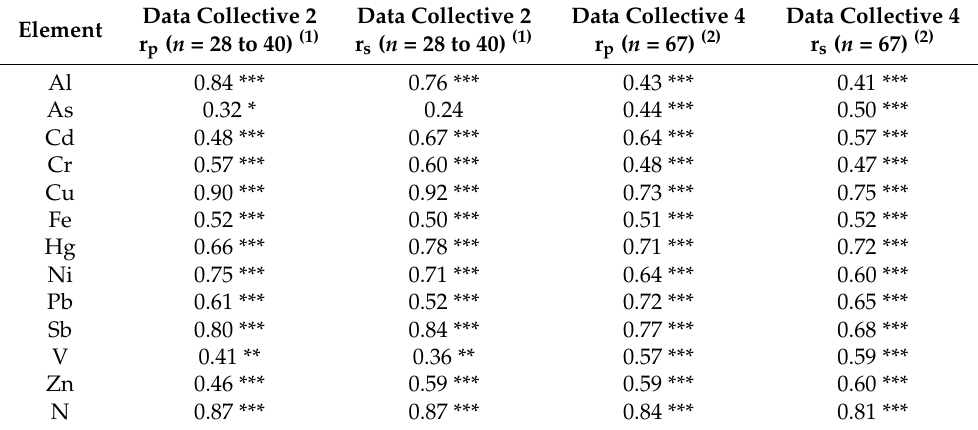
Table 8. Correlation coefficients (Pearson and Spearman) between quotients of element contents in mosses and quotients of leaf area indices based on the Moss Survey 2020 data (data collective 2, cf. Table 6) with respective results based on the Moss Survey 2015 [20] (data collective 4). Element